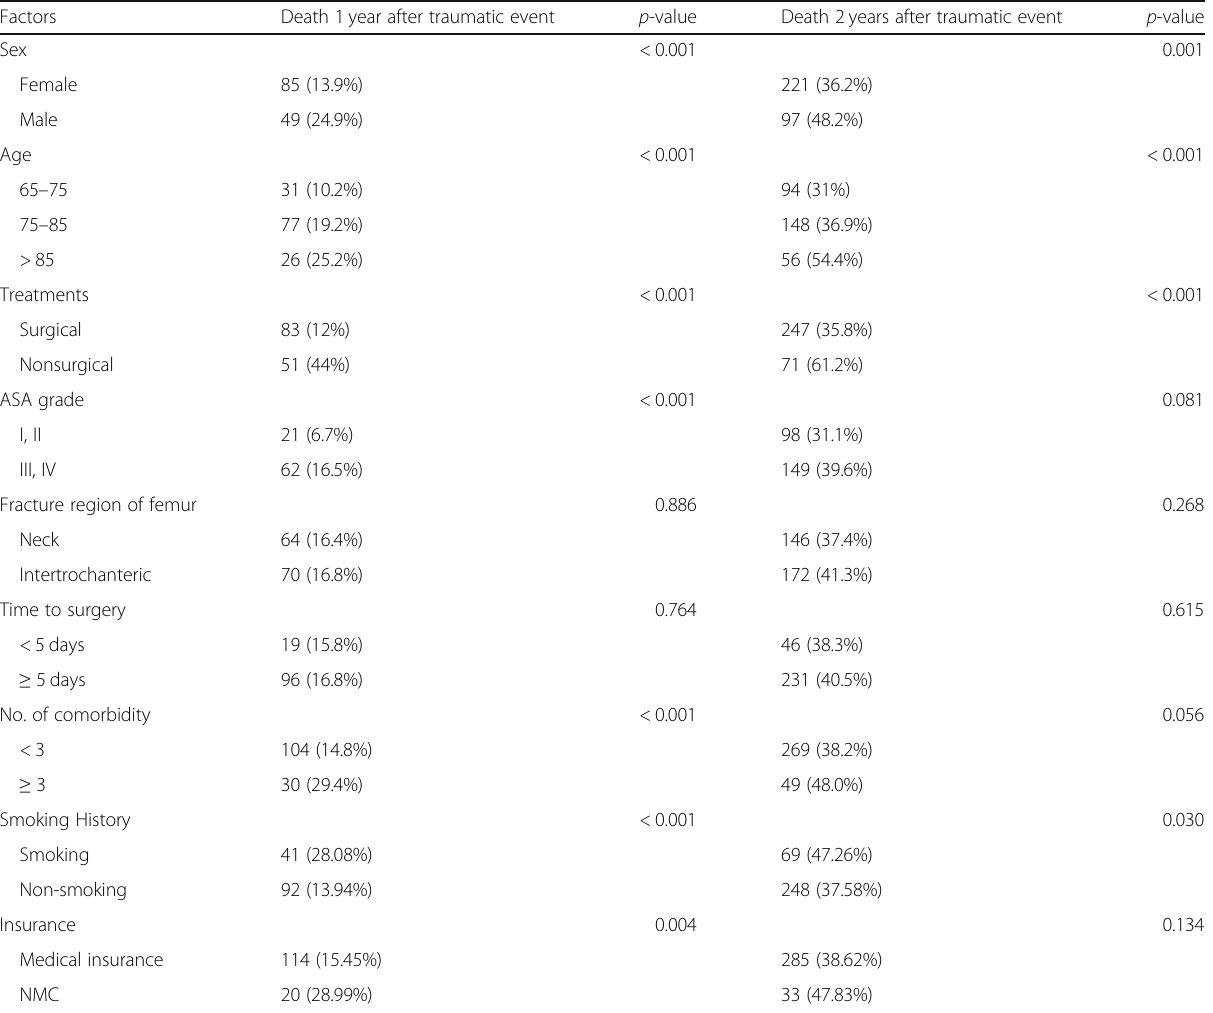
The mortality rates of medical comorbidities are shown in Table 4. The mortality rate 1 year after injury was significantly higher in patients with ≥ 3 comorbidities than patients with less than three comor- bidities ( p = 0.001). In patients with associated comor- bidities such as congestive heart failure, ischemic heart disease, dementia, chronic kidney disease, and cancer, the mortality rates one and 2 years after injury were sig- nificantly higher. Table 2 Influencing factors associated with mortality 1 and 2 years after the traumatic event Factors Death 1 year after traumatic event p -value Death 2 years after traumatic